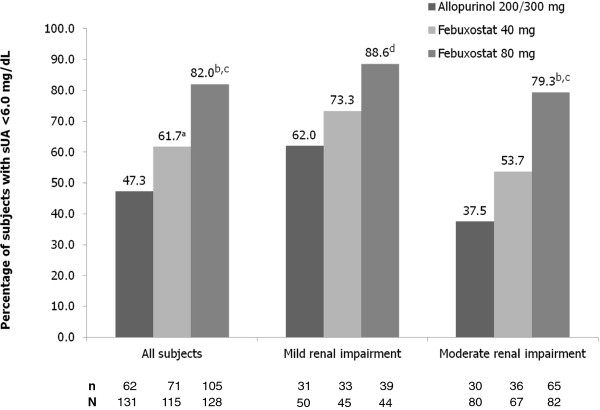
Achievement of sUA <6.0 mg/dL--All Subjects (Primary Endpoint) and by Renal Function. Data regarding the percentage of subjects with normal renal function with sUA <6.0 mg/dL is not presented due to the low number of subjects in this group (N = 6). ap = 0.029 vs allopurinol; bp ≤ 0.001 vs febuxostat 40 mg; cp < 0.001 vs allopurinol; dp = 0.004 vs allopurinol.